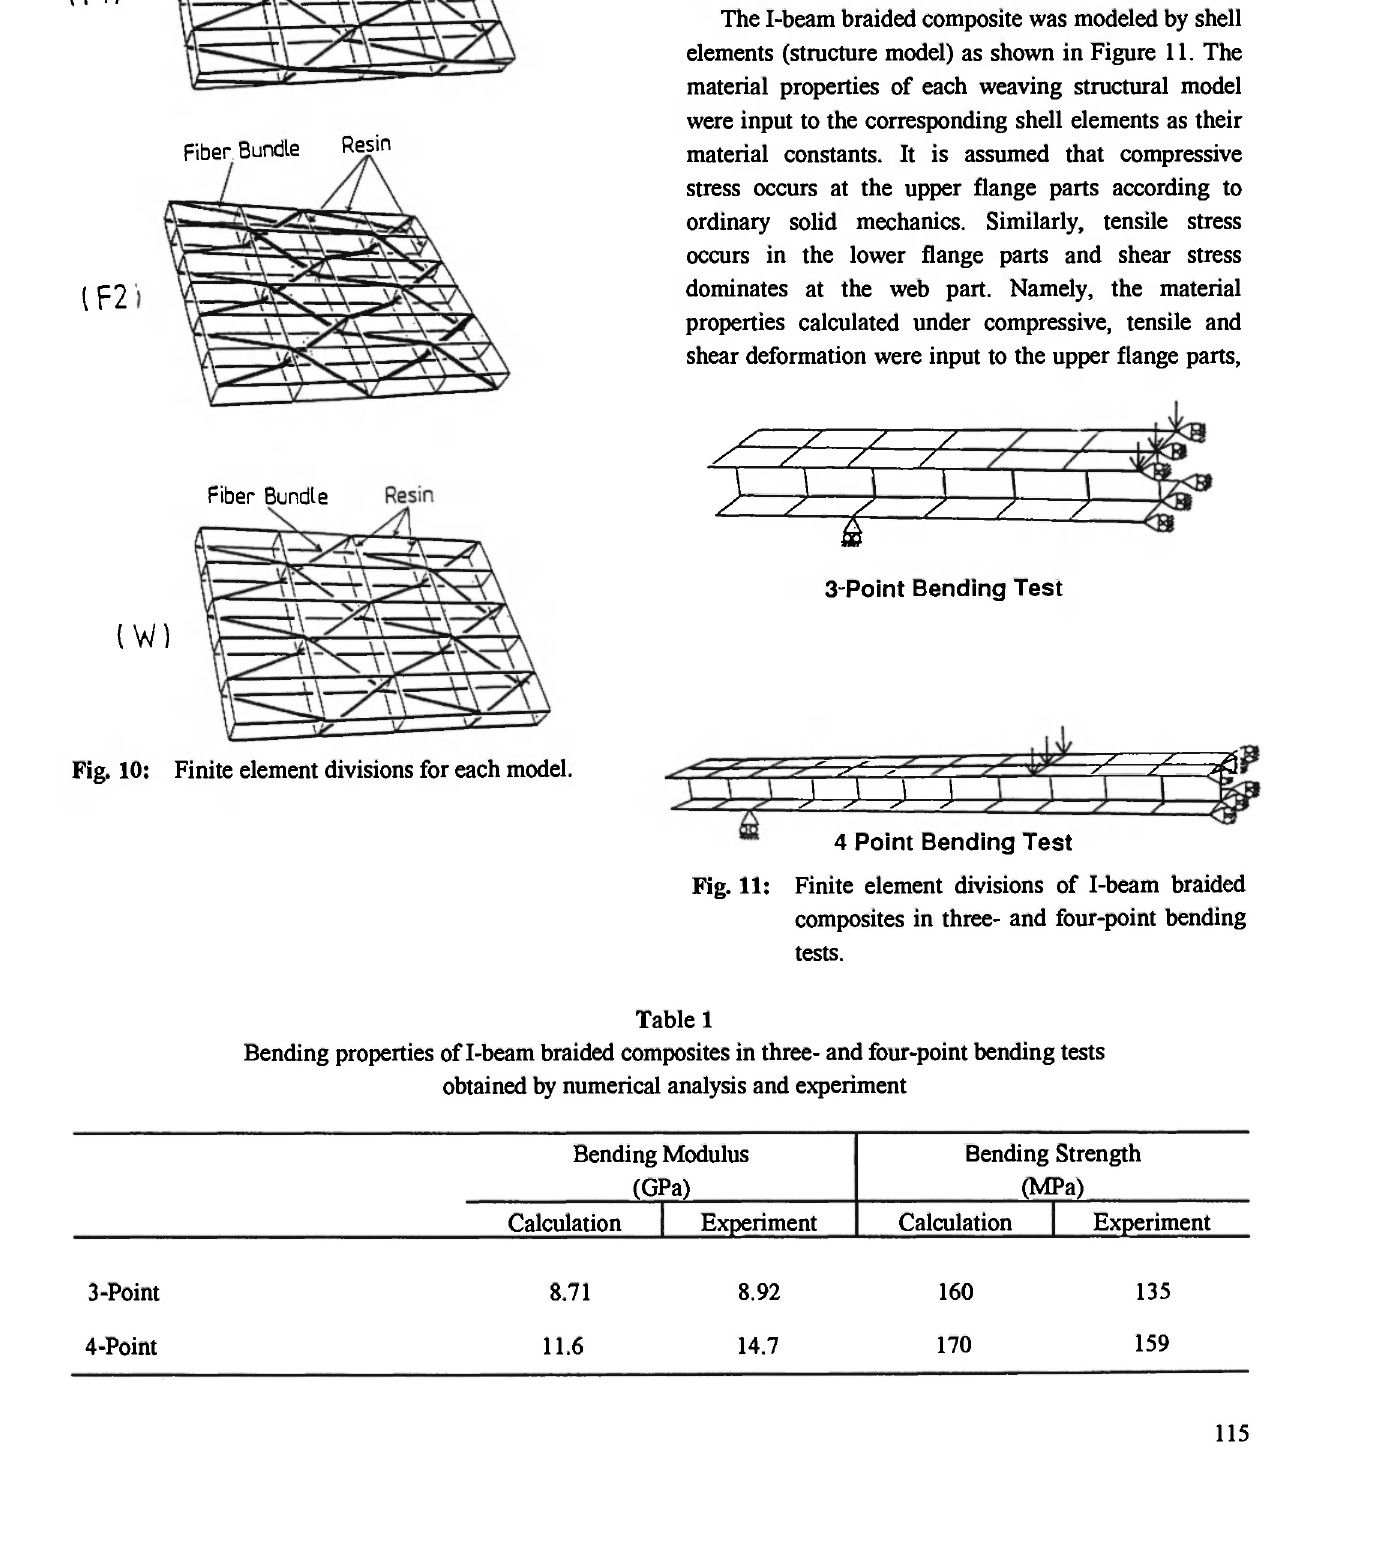
Fig. 10: Finite element divisions for each model.